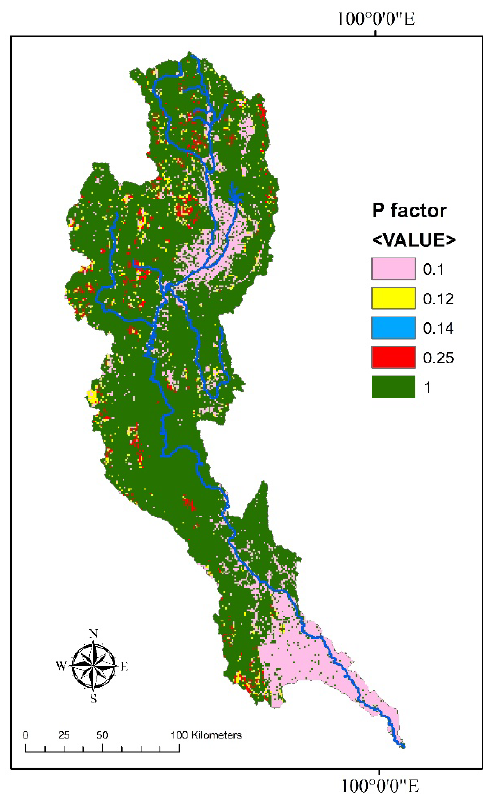
Figure 8. Conservation practice factor.